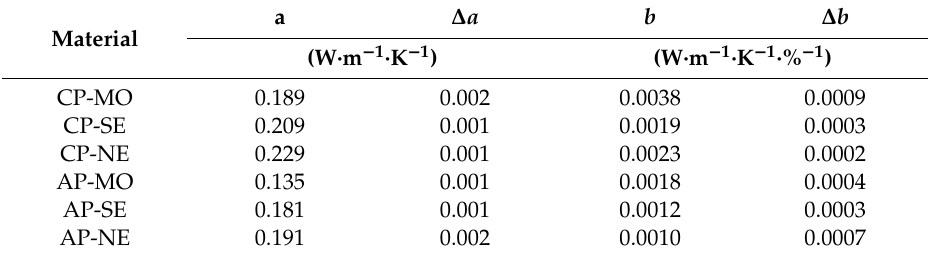
Table 5. The parameters a and b of the linear equations for the six combinations of analyzed materials; ∆ a and ∆ b mean absolute standard error of parameters a and b ,